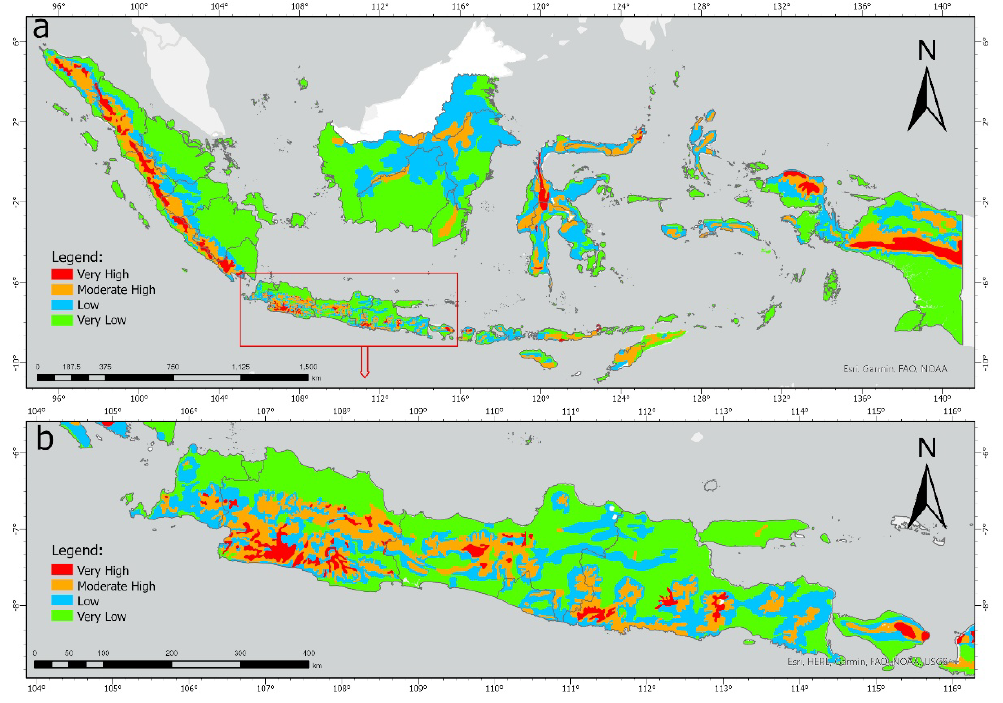
Figure 8. Landslide susceptibility map implemented in the Balai Sabo ILEWS. ( a ) Landslide susceptibility map at the national scale of Indonesia, and ( b ) detailed susceptibility map for Java Island.